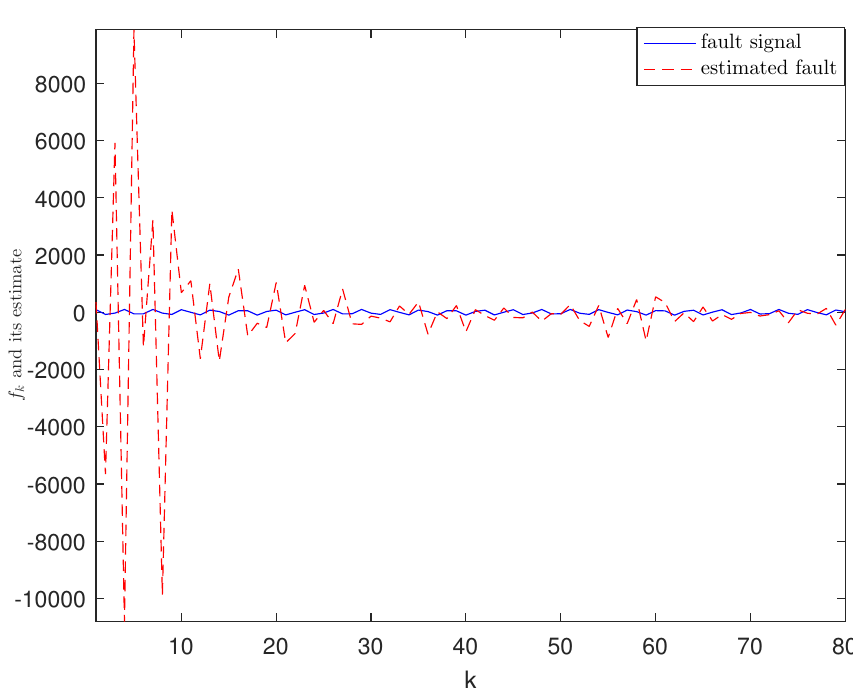
Figure 10. The actual fault and its estimate.